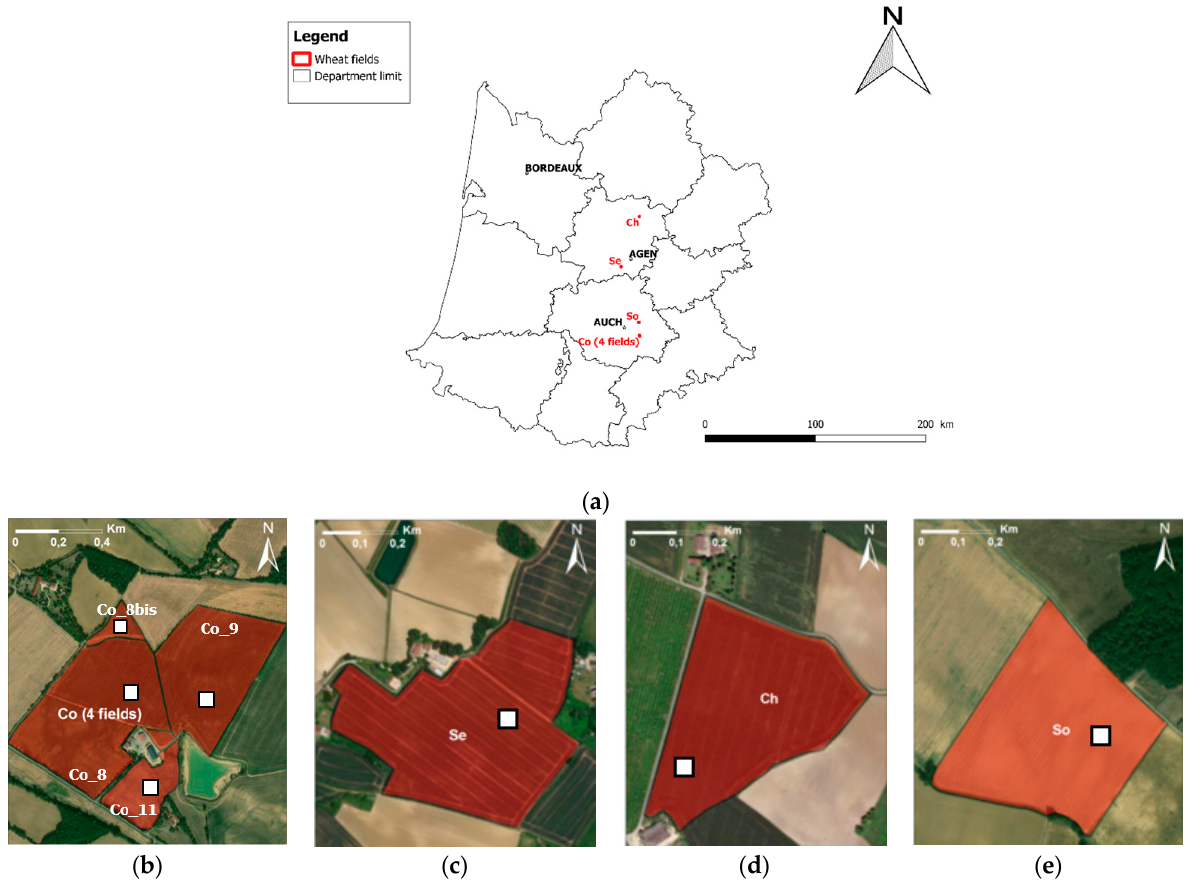
Figure 1. Location of the studied wheat fields in southwestern, France ( a ). Parcels used for ground measurements are displayed in red ( b , c , d and e ). White squares represent the sampling area of vegetation measurements. Main city names are shown in black.